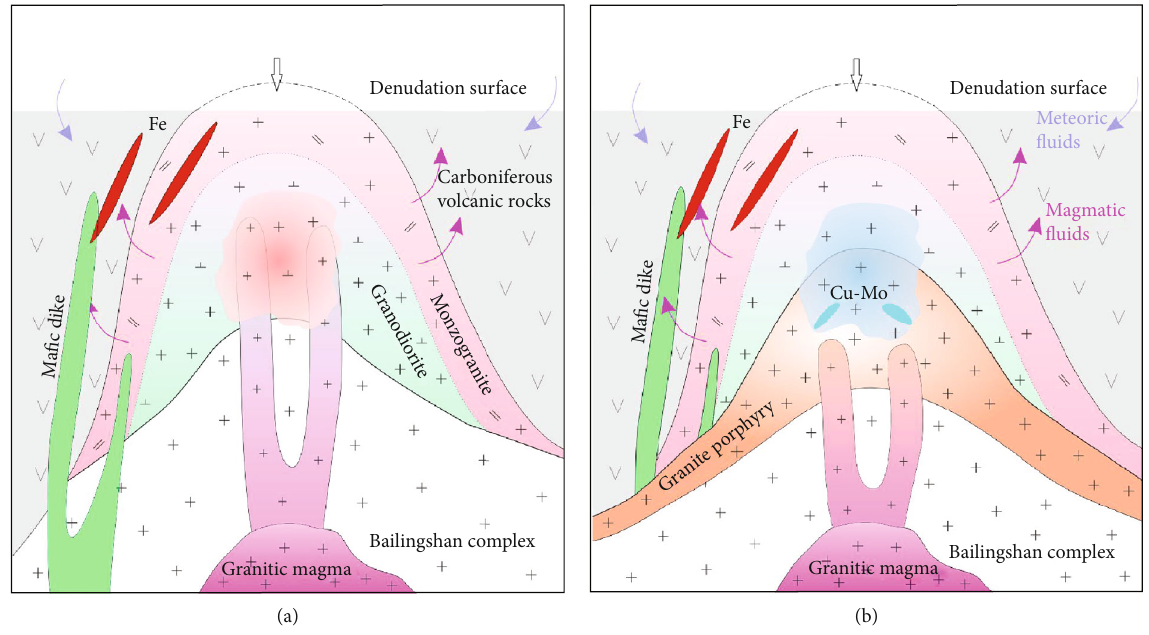
Figure 13: The metallogenic model of the Tieling copper-molybdenite deposit: (a) iron mineralization period in the early Late Carboniferous; (b) copper-molybdenum mineralization at the end of the Late